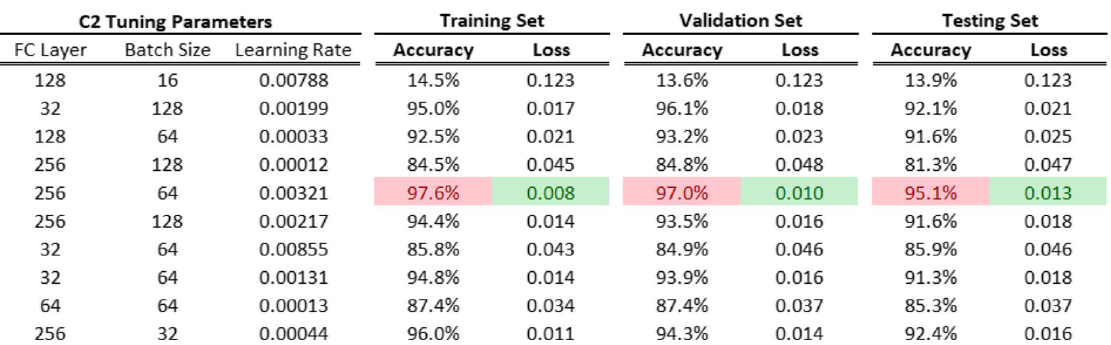
Table 6 Hyperparameter tuning for